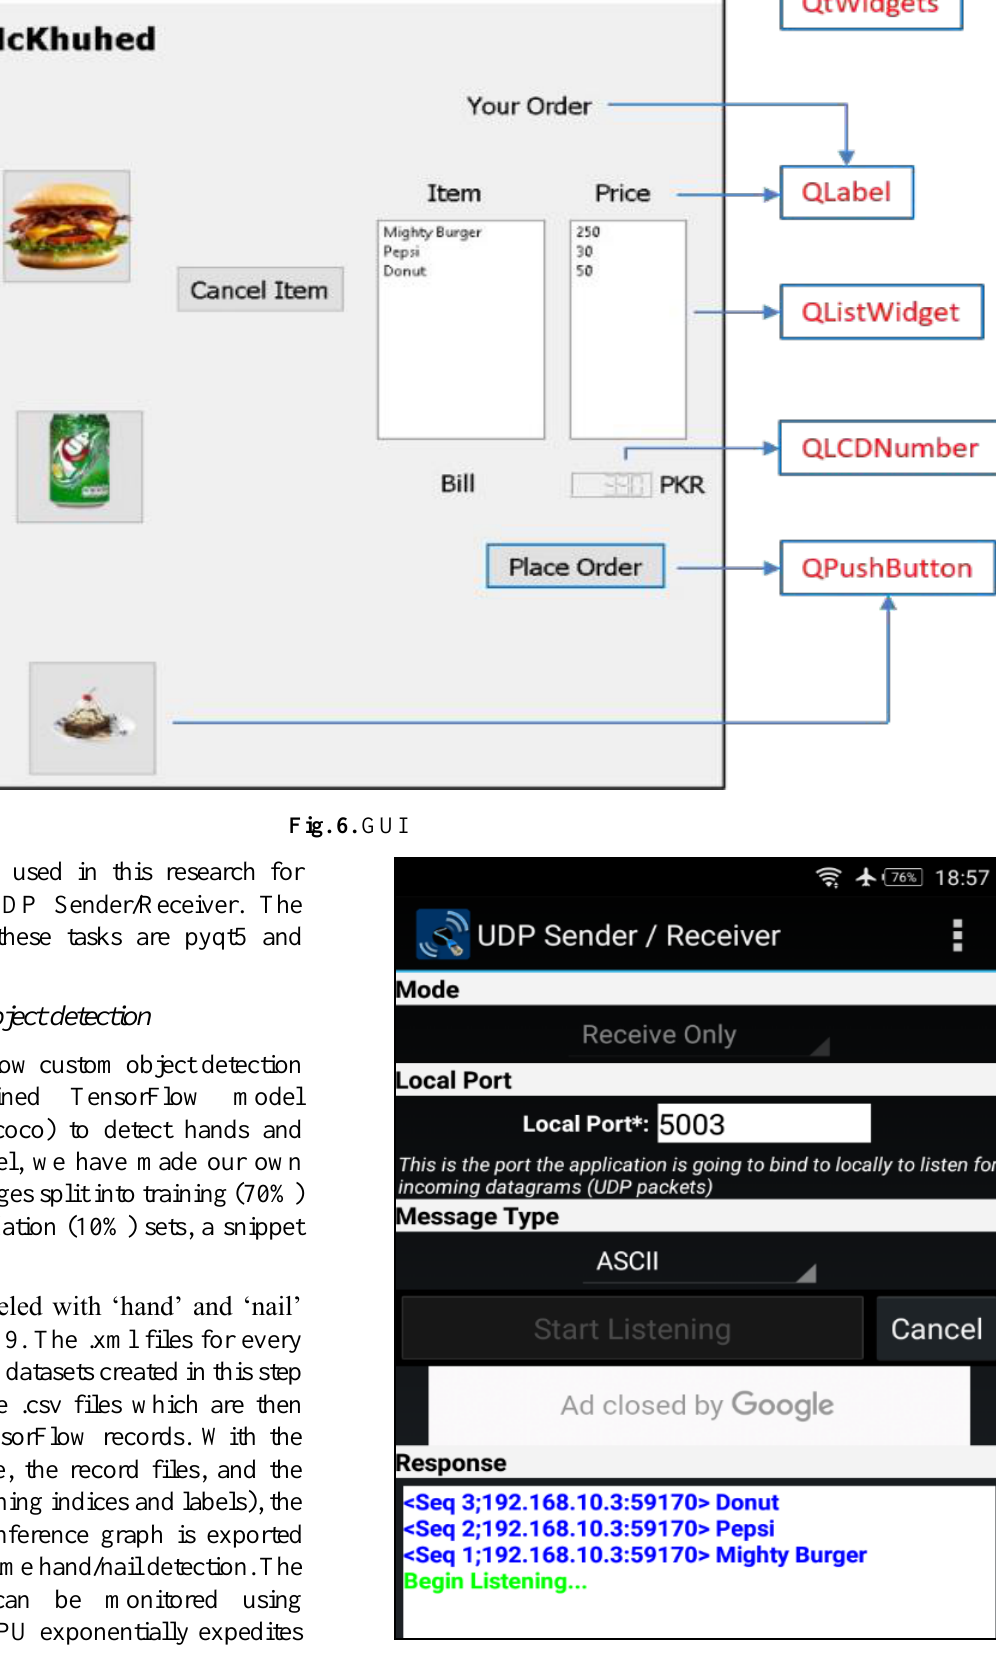
Fig. 7. UDP receiver placed in a